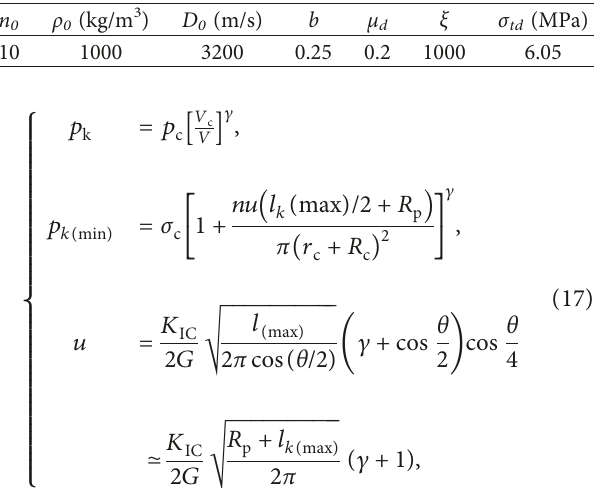
Figure 9: Effects of k r on the development of main Table 2: Mechanical parameters of rock mass.